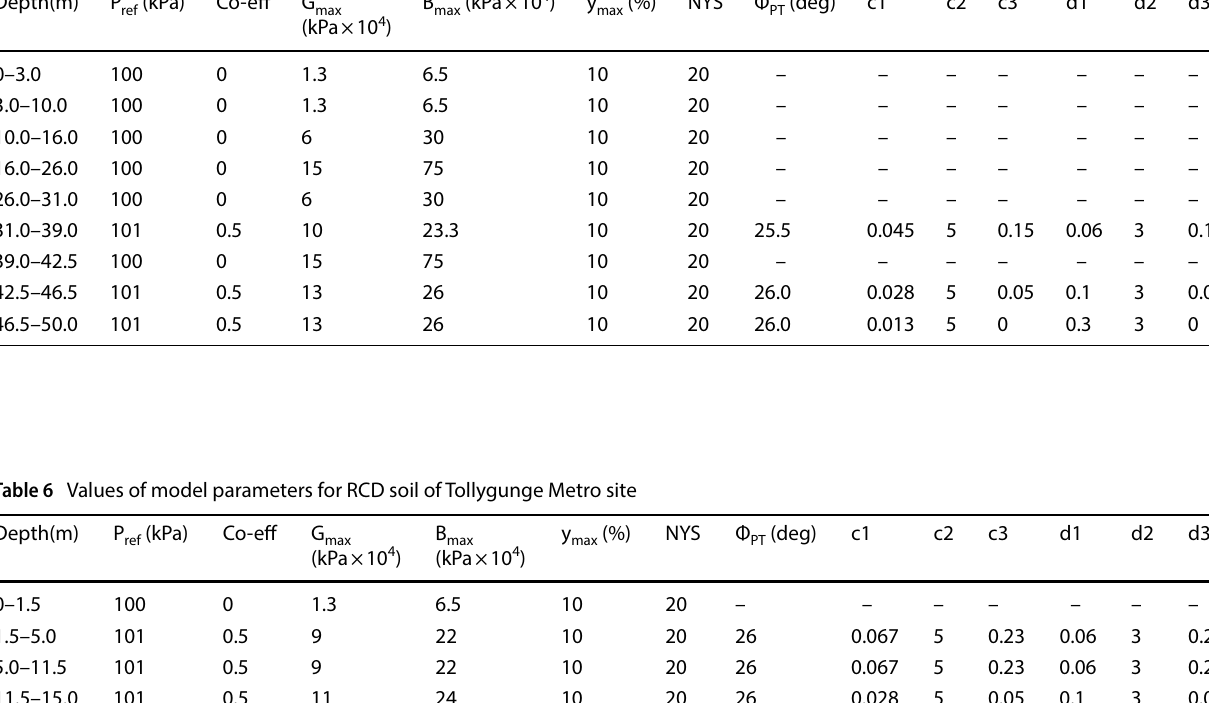
Table 5 Values of model parameters for NKD soil of Ultadanga site Depth(m) P (kPa) ref